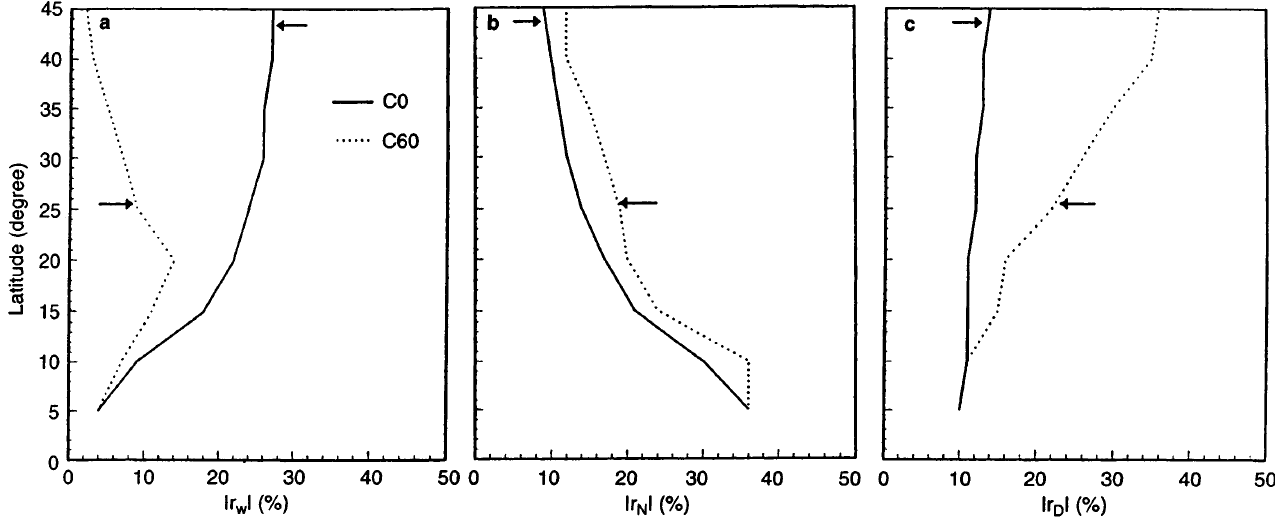
Fig. 11a–c. Linear energy flux coe(cid:129)cient (% ) at di(cid:128)erent latitudes ( (cid:14) ). (a) r W , (b) r N and (c) r D . Solid line for C0. Dotted line for C60. The arrows indicate the critical latitude values for the investigated boundaries. T (cid:136) 360